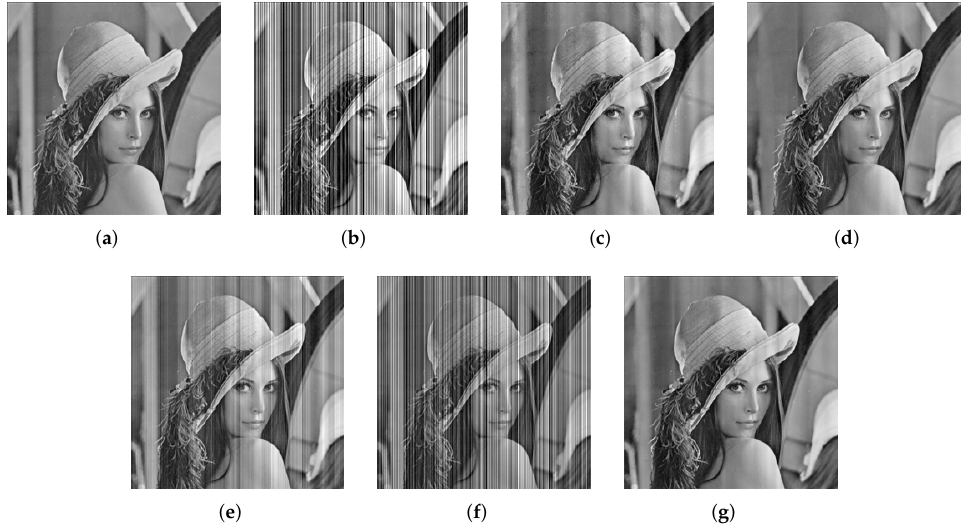
Figure 6. Filtered results for Lena corrupted by stripe niose with σ = 0.16. ( a ) Clean; ( b ) Noisy; ( c ) WTSF; ( d ) MIRE; ( e ) GIF; ( f ) CNN; ( g )